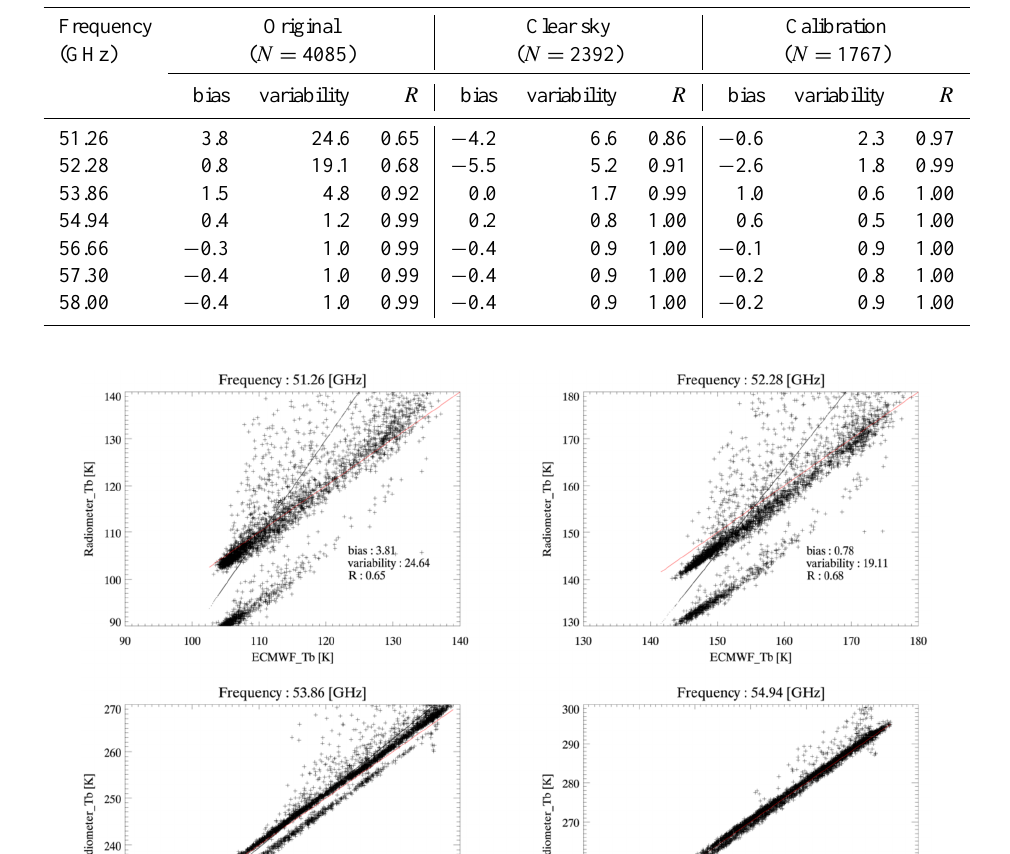
Table 2. Summary of the comparison results between T E removing cloudy data (clear sky), and after further screening of data produced during the faulty calibration (calibration). The number of data points for the three cases are 4085, 2392, and 1767, respectively (Unit:K).